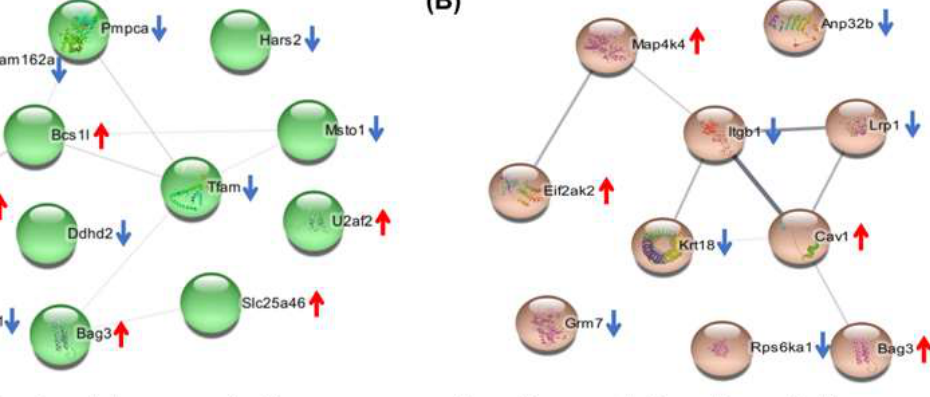
Molecules 2022 , 27 , x FOR PEER REVIEW